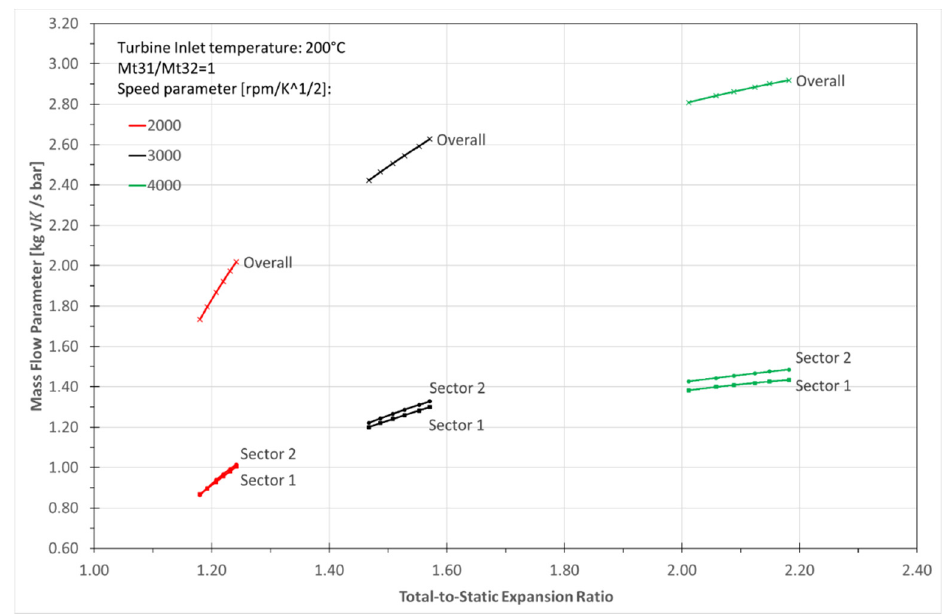
(cid:105) (cid:104) rpm (cid:4675) . Figure 7. Comparison between MFP, MFP1, and MFP2 for Mt31/Mt32 = 1 at N √ . t = 4000 √(cid:2895) K